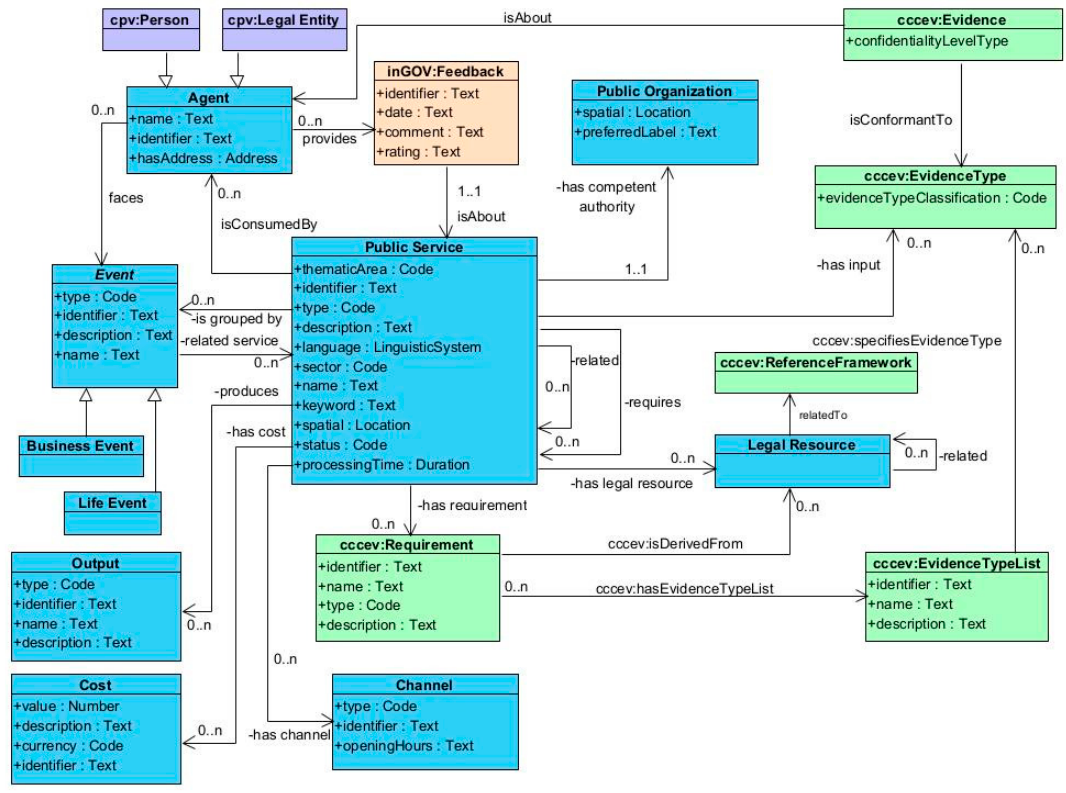
Figure 3. The main classes of the enhanced CPSV-AP 2.2.1